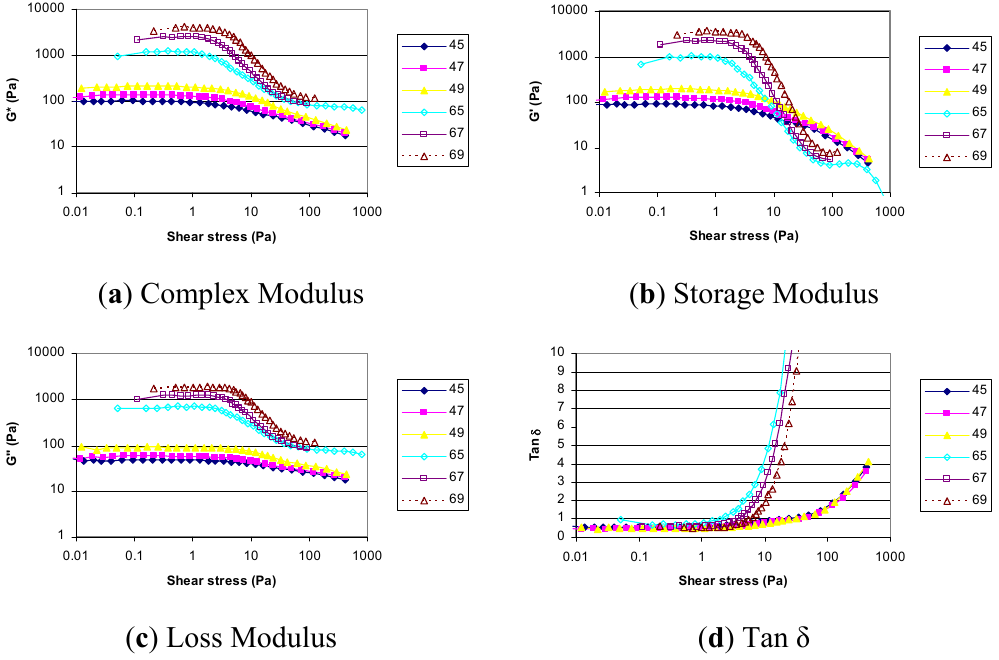
Figure 1 . Rheological characteristics for each silver material ( a ) viscosity over medium shear range, elastic ( b ) and viscous ( c ) modulii and ( d ) Tan δ